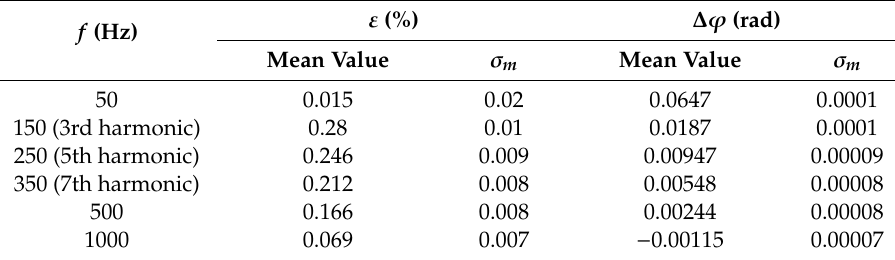
Figure 6. Reference input sinc signal applied to the LPVT under test, measured by reference resistive–capacitive voltage divider and the input sinc signal measured by the LPVT under test (LPVT sinc-response transferred to the primary side). Table 2. Experimental SR test results in terms of 𝜀 and ∆𝜑 .